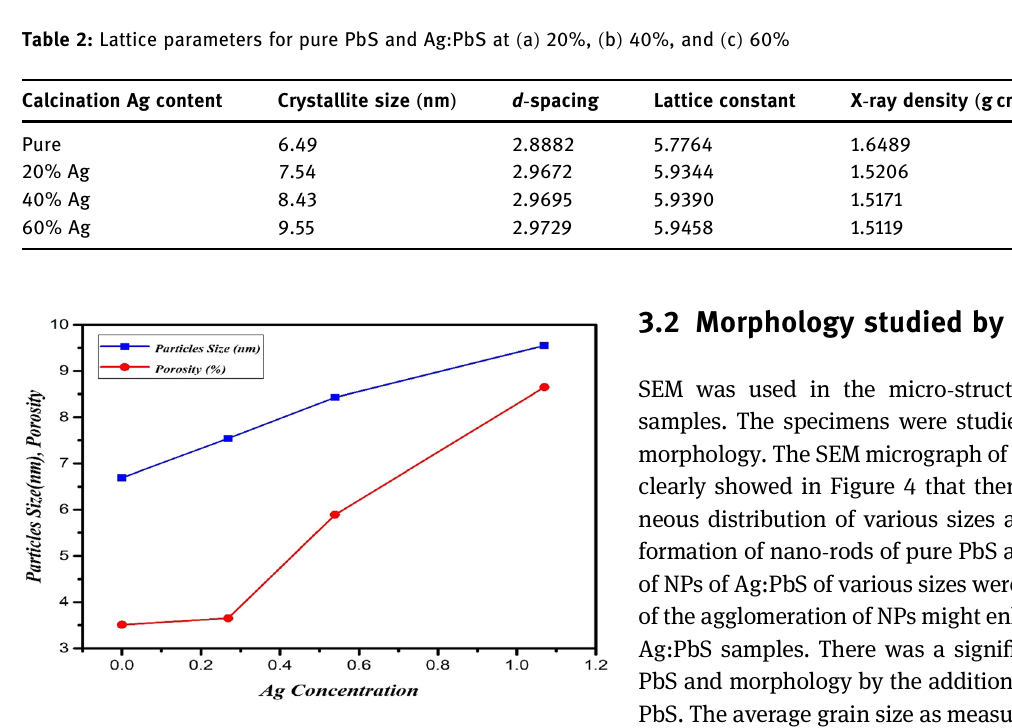
Figure 3: Ag concentration and particles size, porosity of undoped and doped PbS.